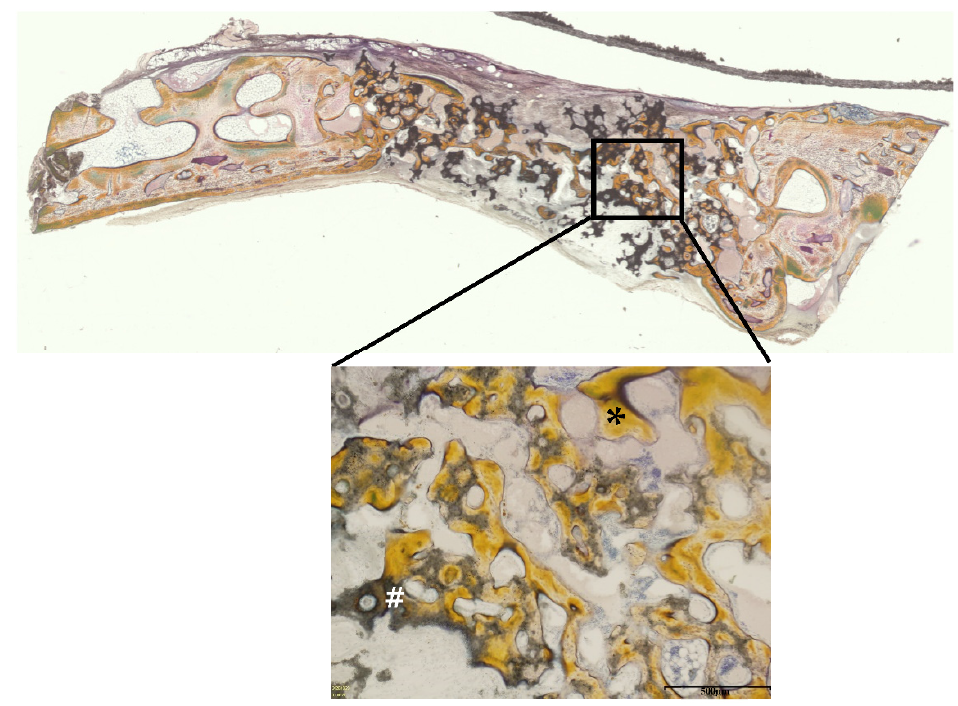
Figure 16. Villanueva bone stain images four weeks after filling of biphasic HA granules. (*: newly formed bone, #: HA granules, scale bar: 500 μ m).